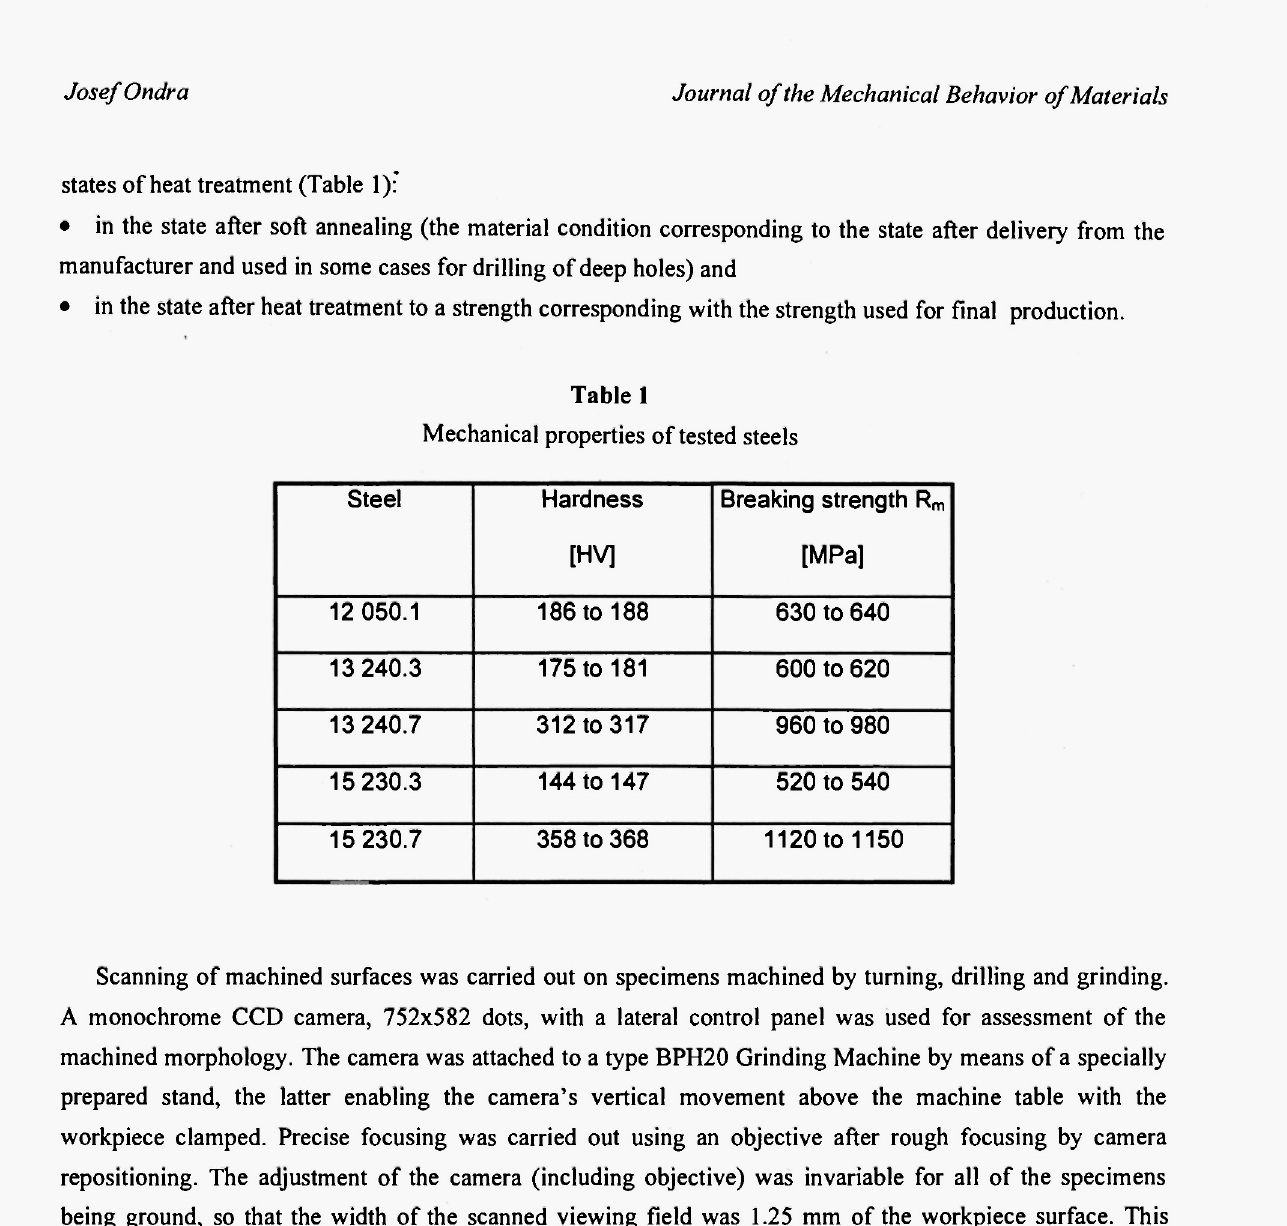
Mechanical properties of tested